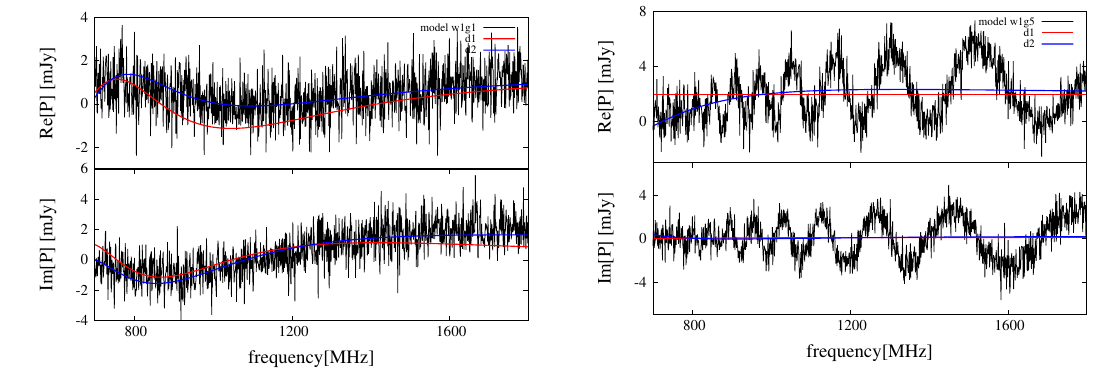
Figure 6. Estimated Stokes Q (top) and U (bottom) spectra by the d1 (red) and d2 (blue) fitting models for the w1g1 (left) and w1g5 (right) source models, respectively. These black lines show the source model Stokes Q,U